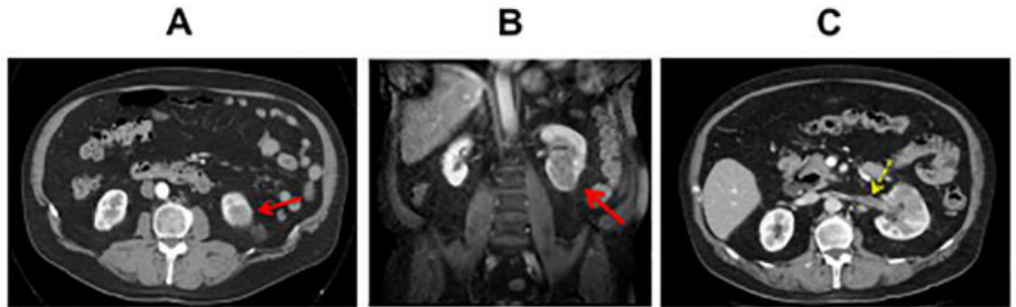
Figure 1. A. Axial postcontrast CT image demonstrating the 2 cm cortical based mass in the inferior left kidney (red arrow). B. Coronal postcontrast fat-suppressed T1-weighted MR image demonstrating the 4.5 cm infiltrative mass in the inferior left kidney. C. Demonstrates a filling defect in the left renal vein (yellow arrow), representing tumor thrombus, approaching but not quite extending into the